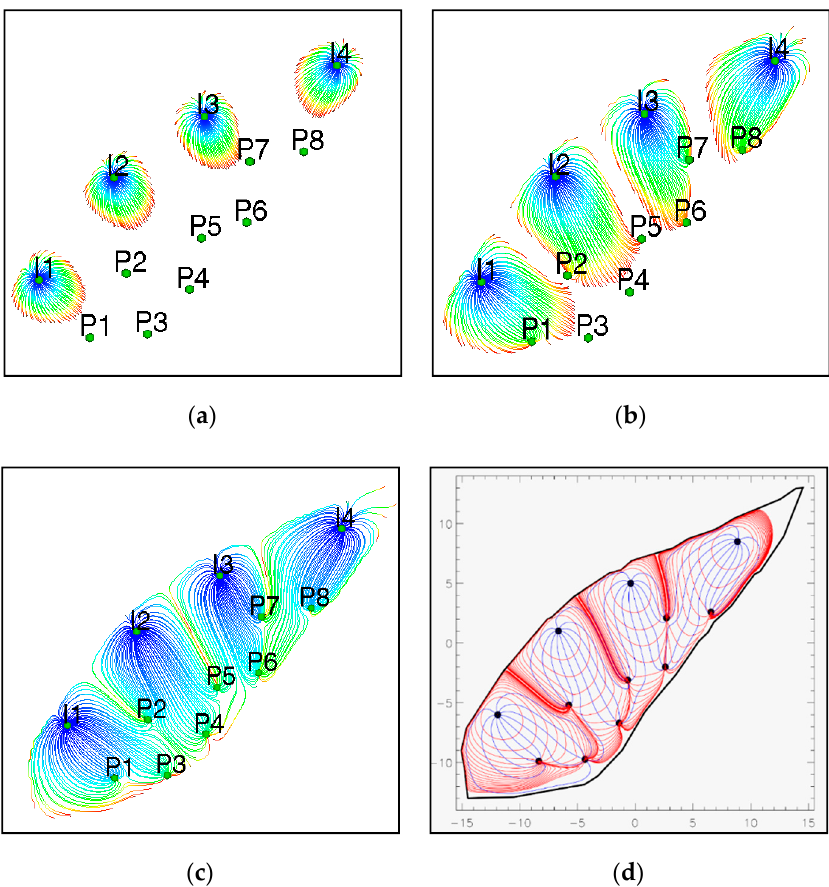
Figure 2. ( a – c ) Grid-based Eclipse simulations of progressive flooding starting from injector wells (I1-I4) in fracture-bounded reservoir space of the Quitman Field (East Texas). Particle paths delineate sweep front travel paths and convective time of flight (rainbow colors) toward the 8 producer wells (P1–P8). ( d ) A grid-less CAM simulation of the same injection pattern gives travel paths (blue lines) and the time of flight contours (red) that nearly perfectly match those of the Eclipse simulation. Reproduced with permission from [3].